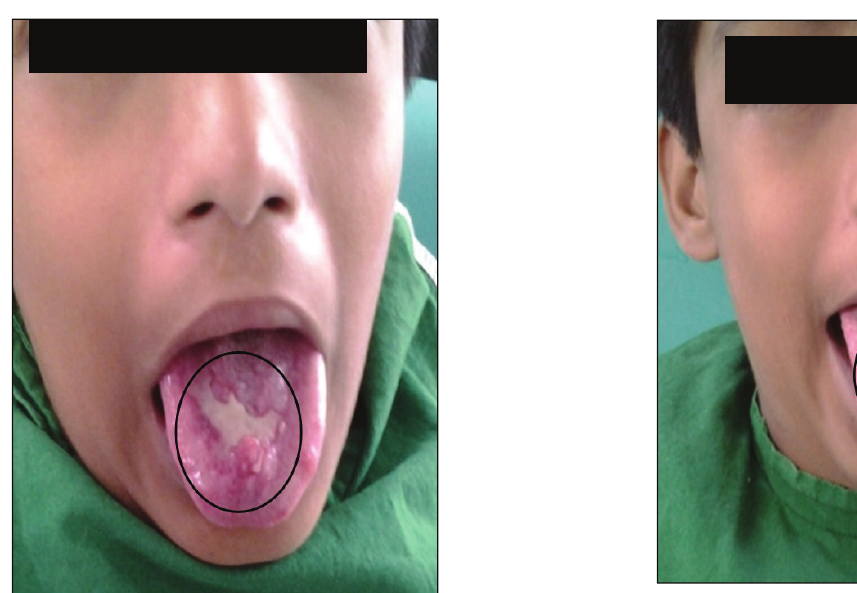
Figure 5: Pretreatment photograph showing ulcer on dorsum of tongue.